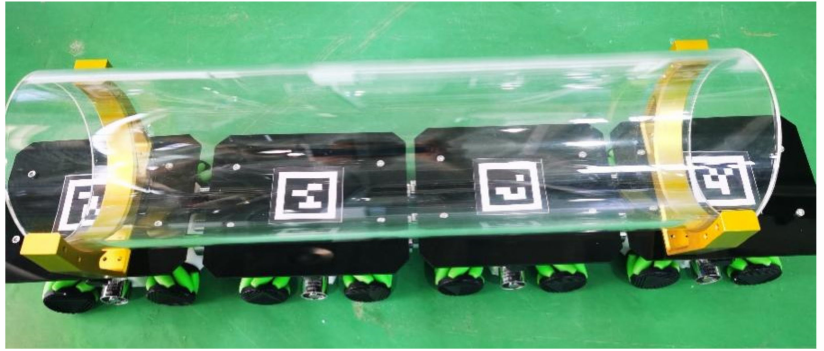
Figure 25. Carrying elongated